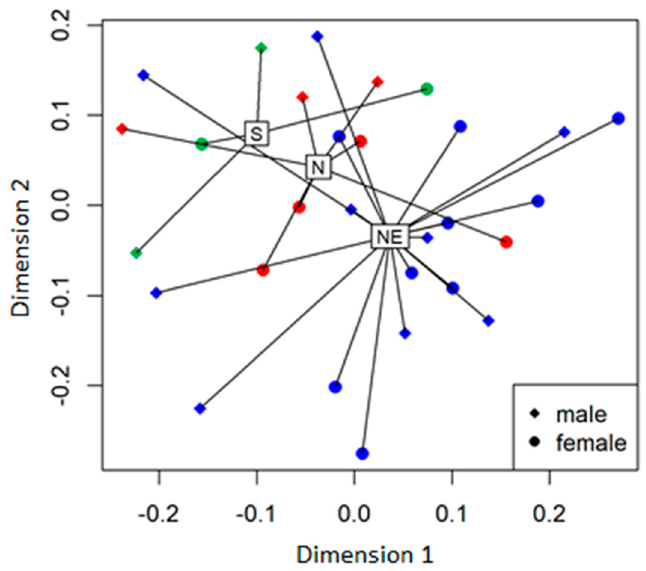
Figure 3. Non-metric multidimensional scaling (NMDS) results based on Bray–Curtis distances of nectar component proportions (sugars and AAs) of Polemonium caeruleum during the male and female flowering phase from 14 populations. Colors indicate groupings by regions, which are significantly different: northern (N)—red, northeastern (NE)—blue, and southern (S)—green (F = 2.34, df = 2, p = 0.04). Each sample is displayed as a square (for the male flowering phase) and a circle (for the female flowering phase).